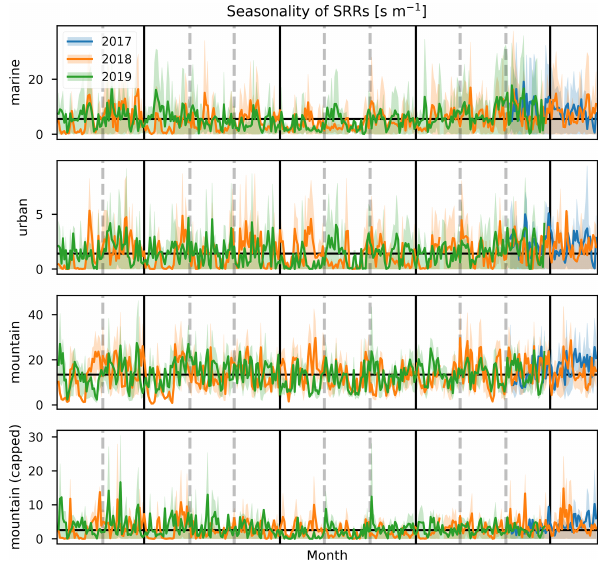
Figure 14. Daily average SRR (sm − 1 ) for marine, urban, moun- tain, and capped mountain categories (top to bottom) obtained from 12h FLEXPART-AROME back-trajectory calculations for the years 2017 (blue), 2018 (orange), and 2019 (green). Interquartile distance is shown as the shaded area in the